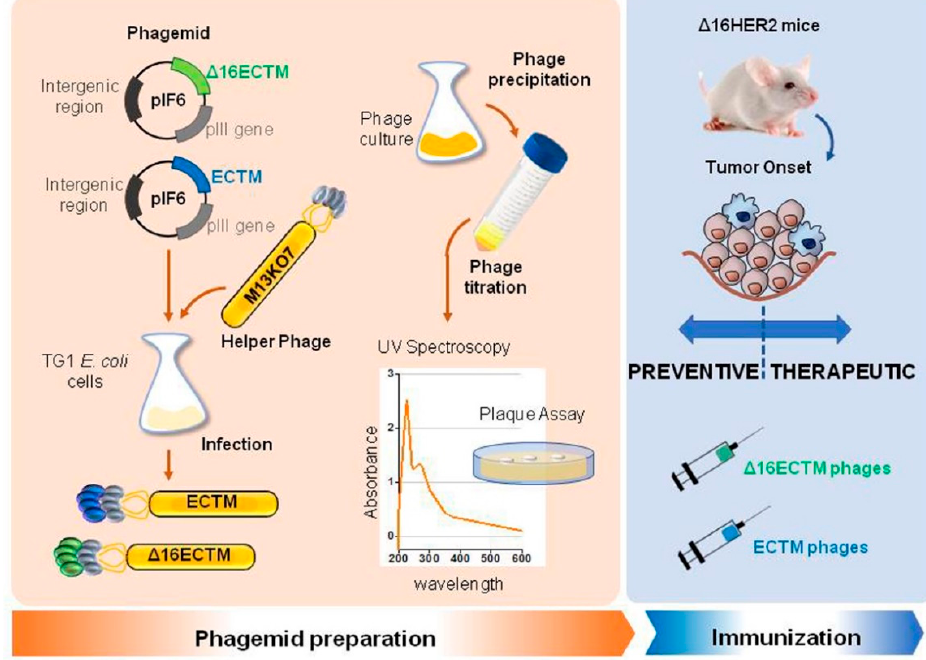
Figure 1. Schematic representation of anti-HER2 phage-based vaccine production.